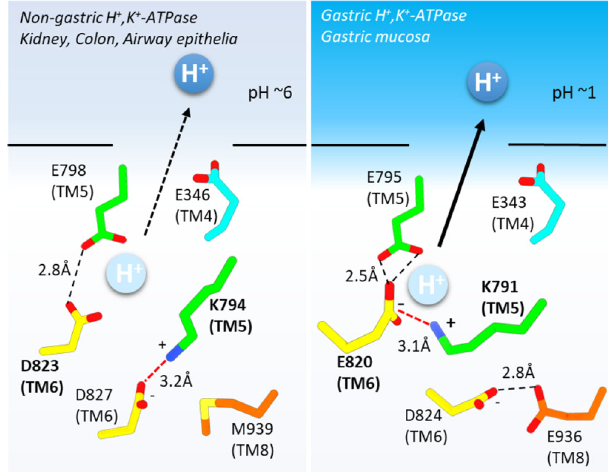
Fig. 2 | Schematic model for proton extrusion for ngHKA and gHKA. See text for